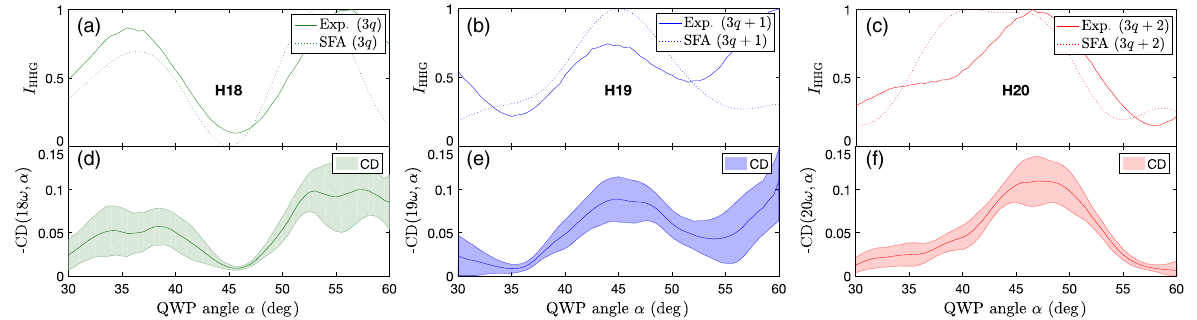
FIG. 2. Ellipticity dependence of the spectral intensity and the CD. (a) – (c) Comparison of the HHG intensity modulations for harmonic orders 18, 19, and 20 of 1800 nm (full lines) with the calculation results (dashed lines) obtained with the theoretical model discussed in the text. The data sets shown correspond to the measurement presented in Fig. 1 for R -MOX. Panels (d) – (f) show the corresponding ellipticity-dependent chiral response CD ð n ω ; α Þ . The strong-field (SFA) calculations have been performed assuming a single-cycle continuous-wave bicircular pulse centered at 1800 þ 900 nm, with intensity of the fundamental driving field set at I 5 × 10 13 W = cm 2 and a field strength ratio of η ¼ F =F 0 . 75 ω ¼ 2 ω ω ¼